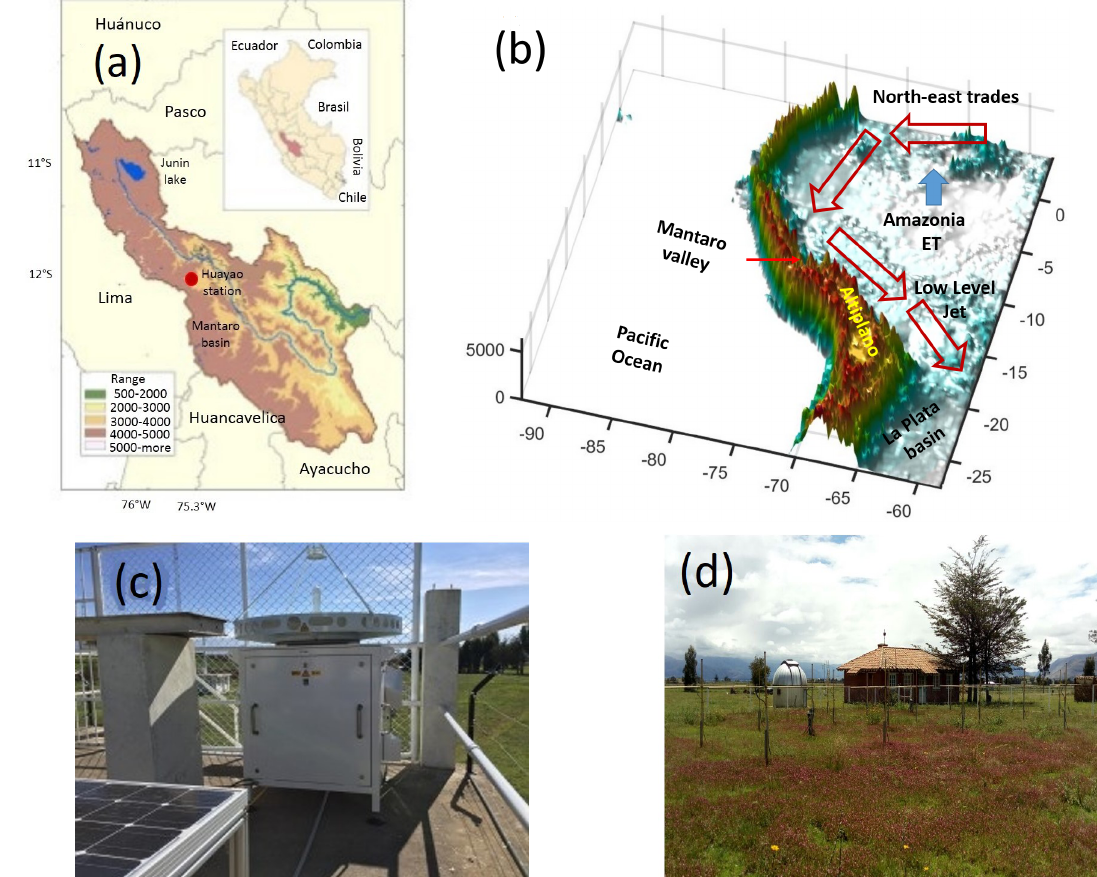
Figure 1. ( a ) The domain of the Mantaro valley and the location of the weather station in the Huancayo Observatory of the “Instituto Geofísico del Perú” (12.05 ◦ S, 75.32 ◦ W, 3313 m a.s.l.); ( b ) Conceptual model of the main components of the SALLJ system at east of the Andes cordillera. The location of the Mantaro valley at the north-west of the Altiplano is indicated; ( c ) Magnetron based pulsed Ka-Band Doppler radar MIRA-35c; ( d ) Boundary Layer and Troposphere Radar (BLTR). Both instruments have been installed in the Huancayo observatory since